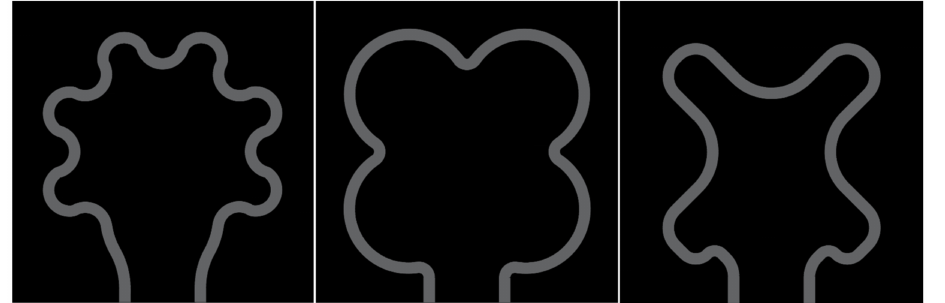
Figure 3. Top view of a section of half plate for the novel configurations for cooling systems based on flower outlines: crateriform ( left ), salverform ( center ), and cruciform ( right ) shapes of